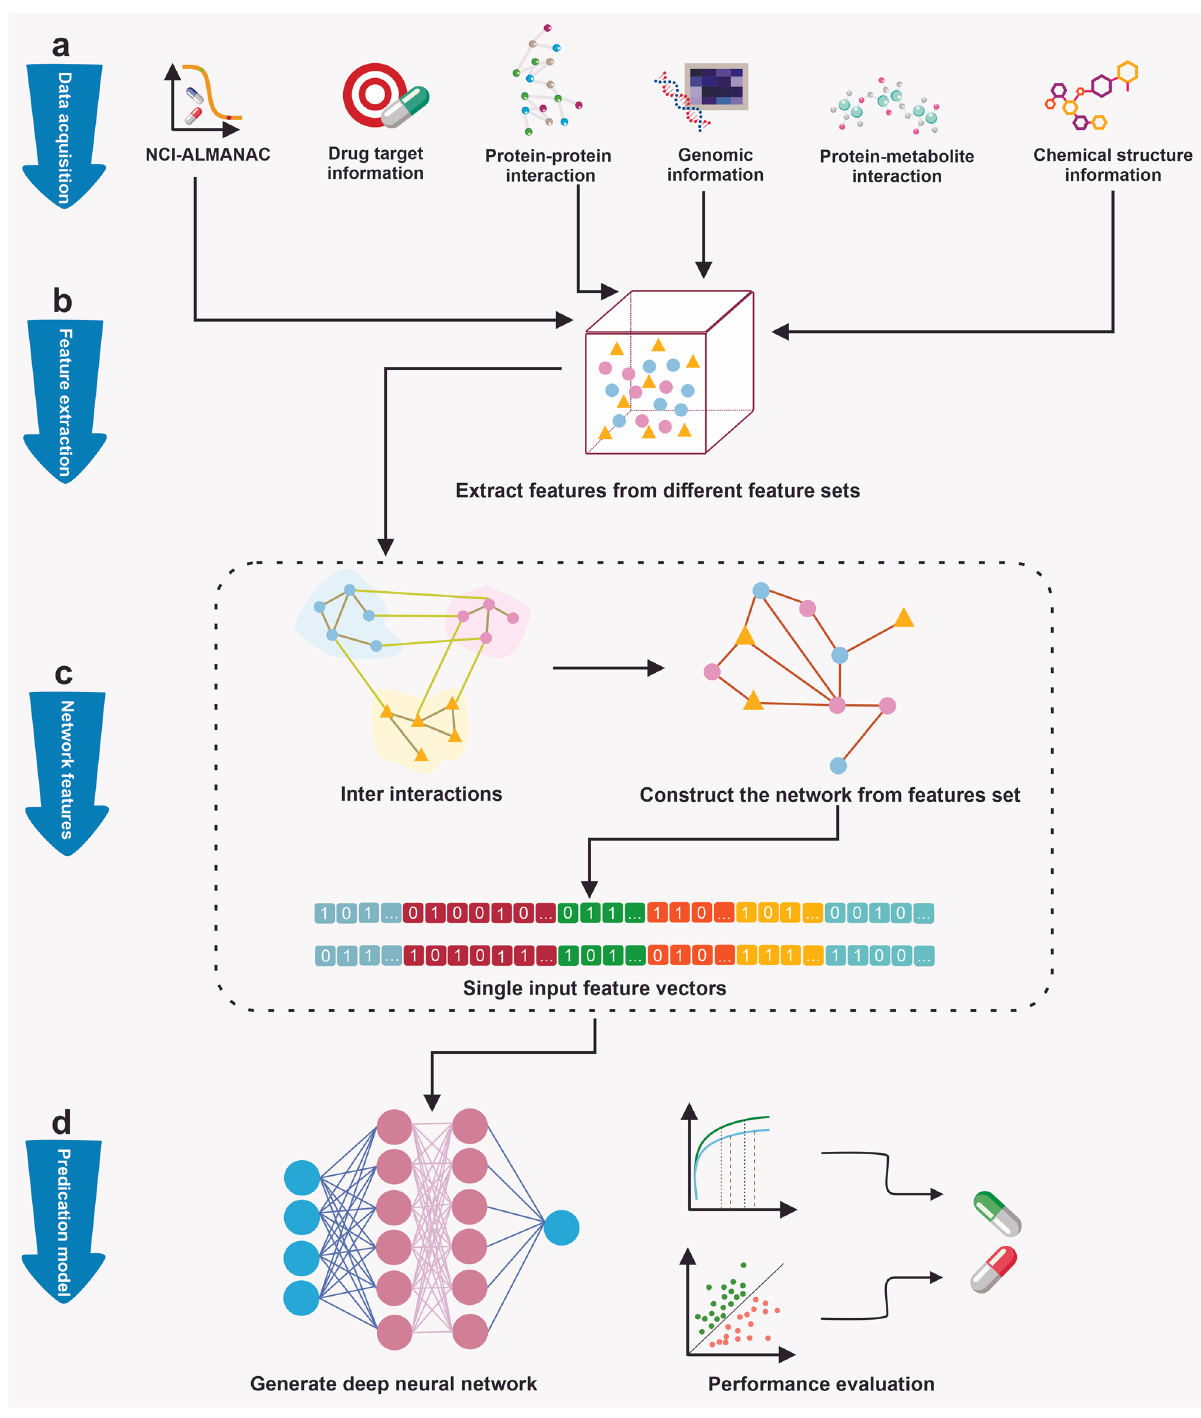
Figure 3. Overall steps to construct drug synergy prediction model. ( a ) eight feature sets were used to predict the synergy effect, drug-target, protein–protein interaction, protein-metabolite interaction, genomic features (gene expression, mutations, and differential methylation), chemical structure, and cell lines. ( b ) Features from different sets were extracted to generate the network. ( c ) The heterogeneous network was created from various features. ( d ) The prediction model was constructed to predict drug combinations’